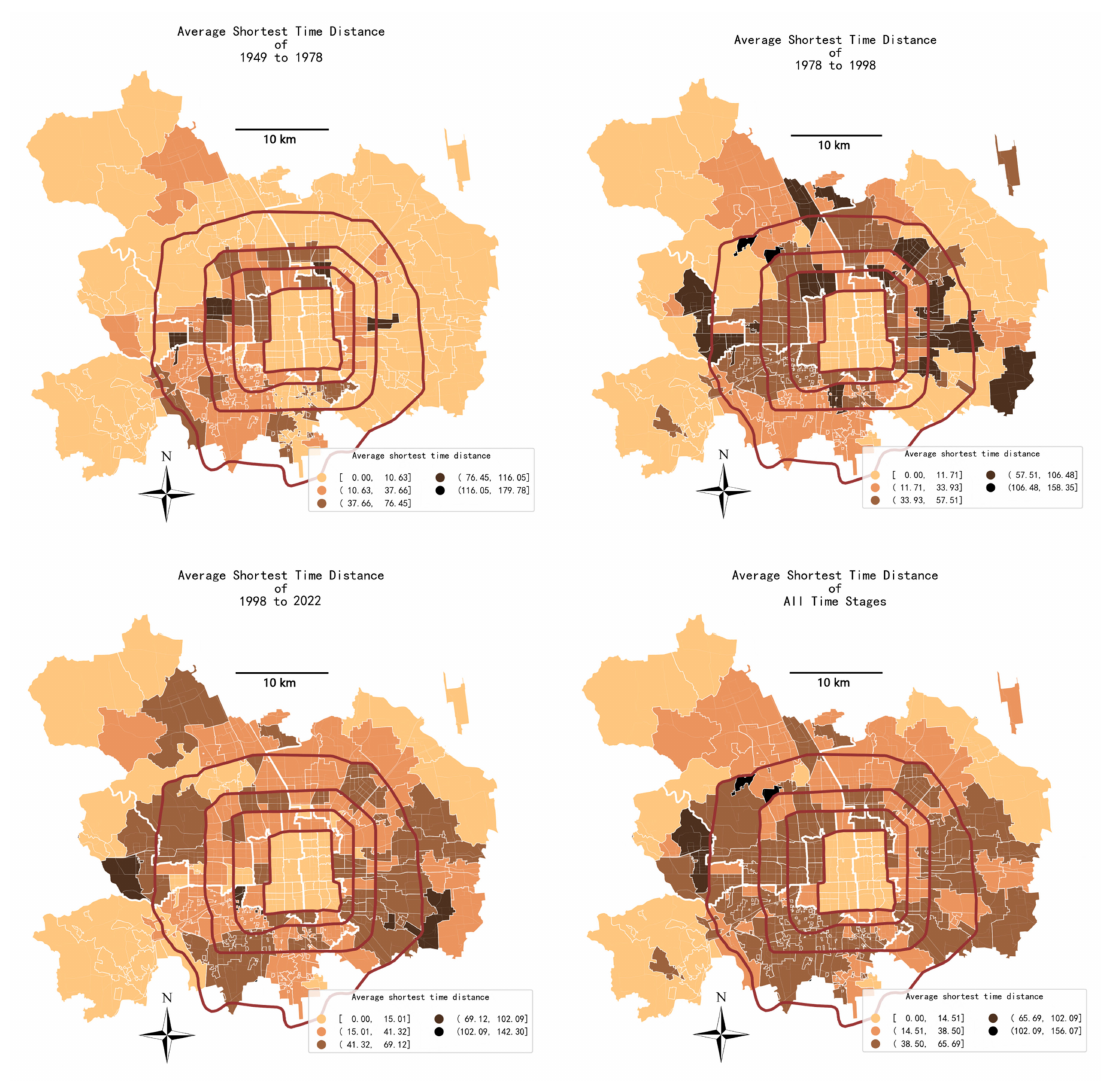
Figure 10. The spatial-temporal patterns of the Shortest Time Distance